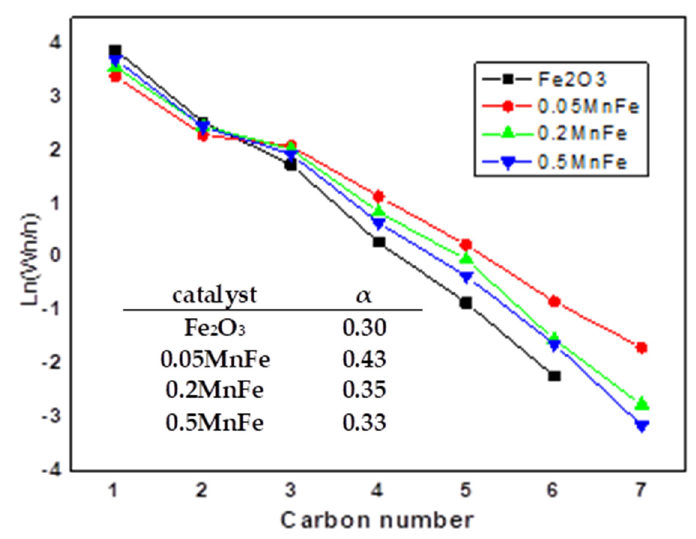
Figure 8. Anderson–Schulz–Flory distribution of the hydrocarbons in the CO 2 hydrogenation over bulk x MnFe catalysts. Reproduced from Ref. [19]. Copyright license from Elsevier (2021).